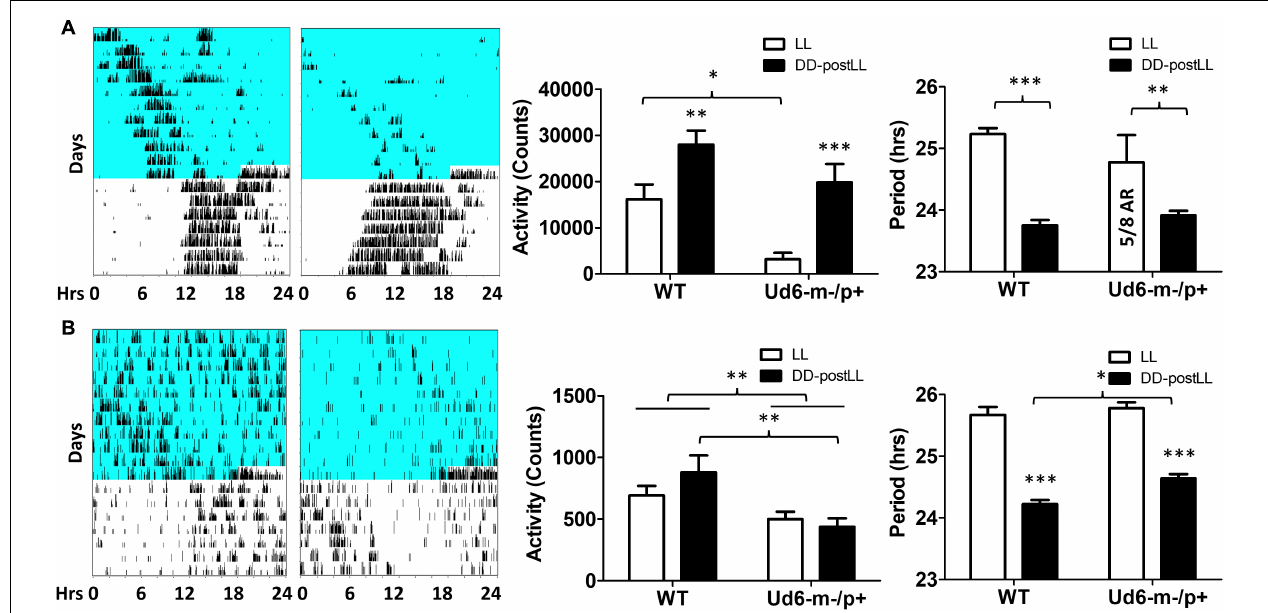
FIGURE 5 | Light suppresses locomotor activity in Ud6-m-/p+ mice. (A) Left, representative wheel-running activity records (actograms) of mice are shown in the double-plotted format. Mice were initially in constant light (LL, blue background indicates light) and were then transferred to constant darkness (DD, white background). Total daily wheel-running activity (middle panel) and period analysis (right panel) during LL and after transfer from LL to DD (“DD-postLL”) were quantified (WT: n = 8, Ud6-m-/p+: n = 8). Data are plotted as mean ± SEM and analyzed by two-way ANOVA. Wheel-running activity (middle panel): p < 0.05 of the genotype factor (WT vs. Ud6-m/p+) and p < 0.001 of the timing factor (LL vs. DD-postLL), ∗ p < 0.05, ∗∗ p < 0.01, and ∗∗∗ p < 0.001 by the Bonferroni posttest as indicated. Wheel-running activity period (right panel): p < 0.001 of the timing factor (LL vs. DD-postLL), ∗∗ p < 0.01, and ∗∗∗ p < 0.001 by the Bonferroni posttest as indicated. (B) Left, representative total activity was monitored by infrared motion sensors in LL and DD from WT and Ud6-m-/p+ mice. Total daily activity by infrared sensors (middle panel) and period analysis (right panel) during LL and DD-postLL were quantified (WT: n = 6, Ud6-m-/p+: n = 6). Data are plotted as mean ± SEM and analyzed by two-way ANOVA. Infrared activity (middle panel): p < 0.01 of the genotype factor (WT vs. Ud6-m/p+), p < 0.01 by the Bonferroni posttest as indicated. Infrared activity period (right panel): p < 0.001 of the timing factor (LL vs. DD-postLL), ∗∗∗ p < 0.001 by the Bonferroni posttest for LL vs. DD-PostLL, ∗ p < 0.05 as